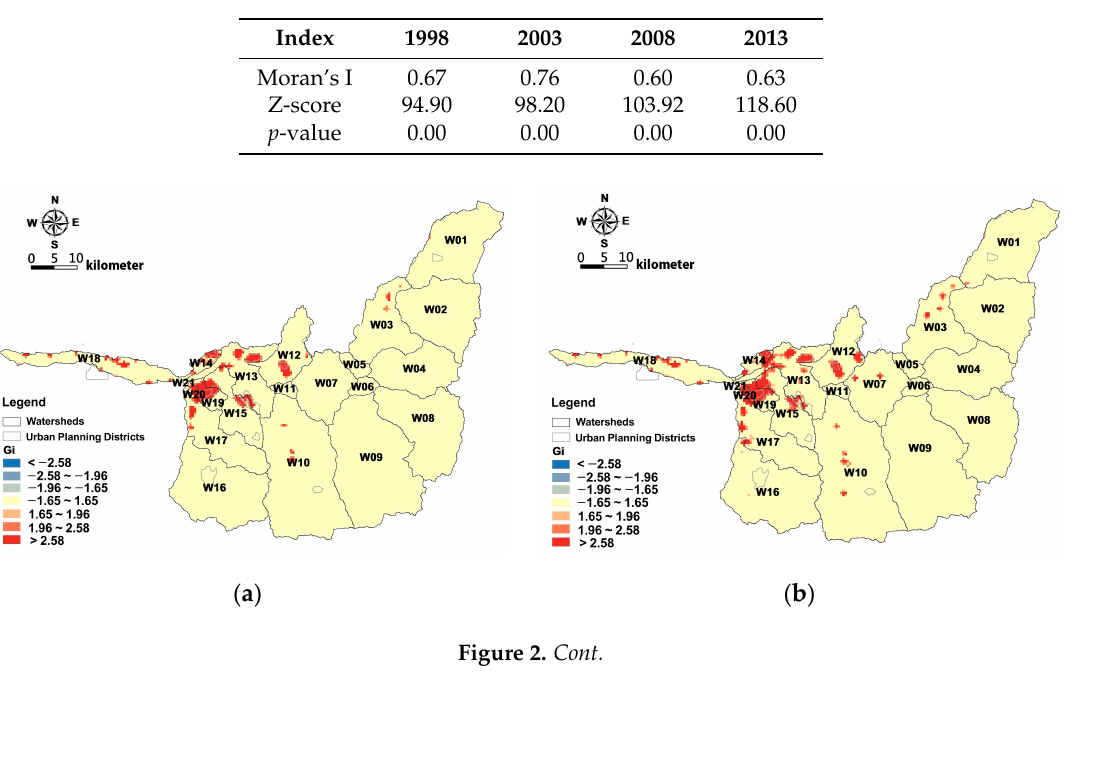
Table 6. Spatial autocorrelation of artificial structures from 1998 to 2013.